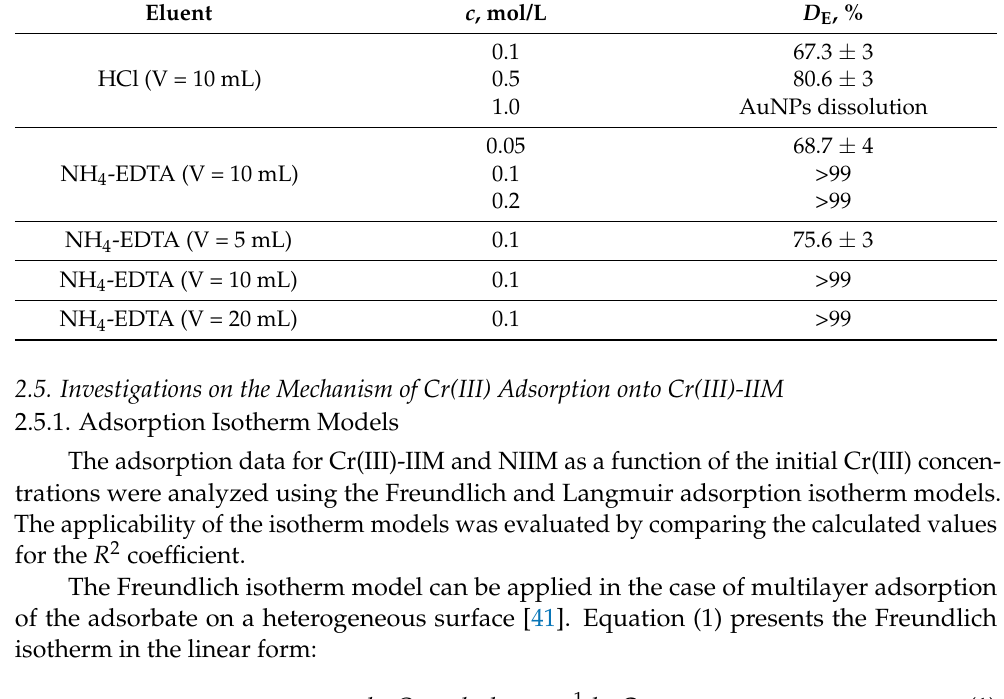
Table 1. Degree of elution D E (%) of Cr(III) from Cr(III)-IIM using different eluents. Eluent c , mol/L D E , % 0.1 67.3 ± 3 0.5 80.6 ± 3 HCl (V = 10 mL) 1.0 AuNPs